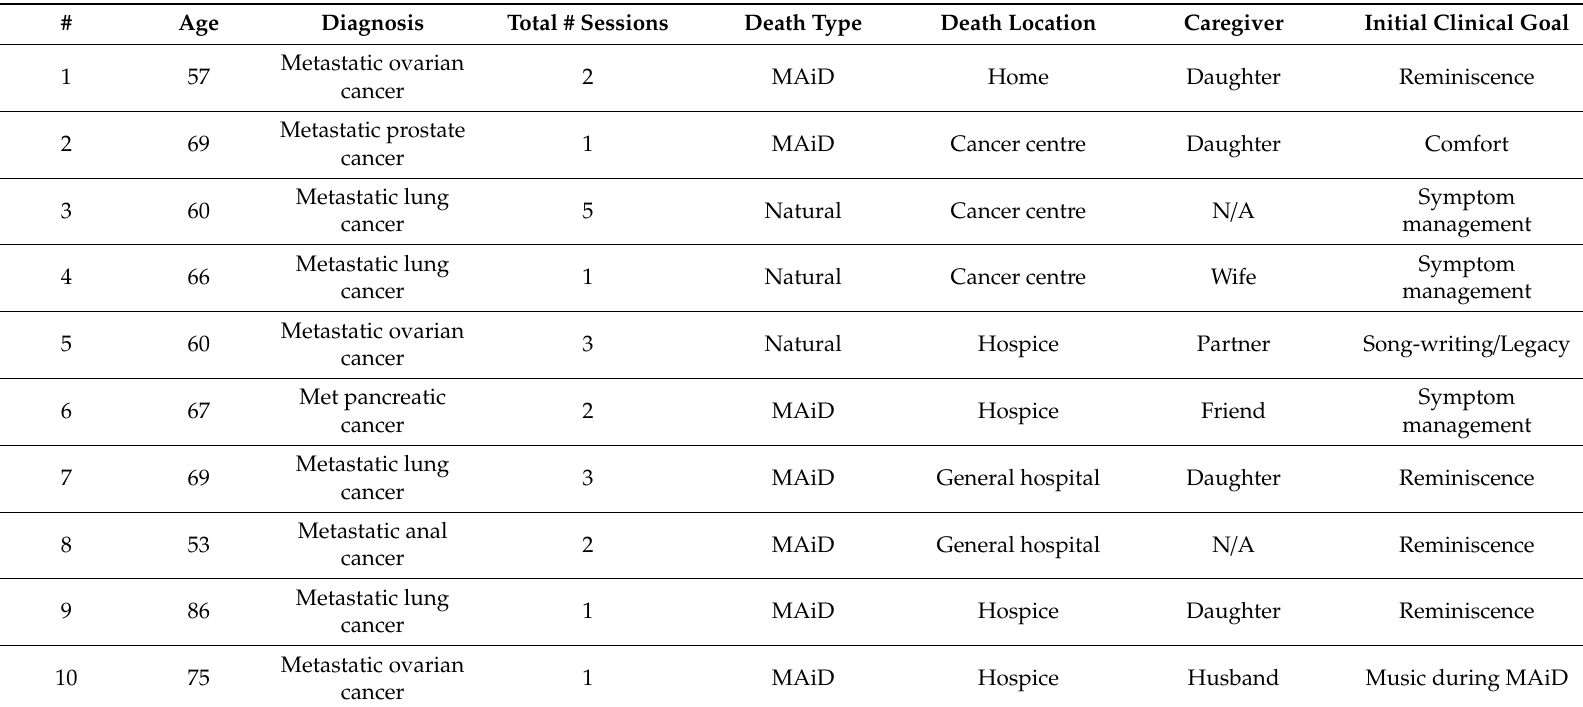
Table 1. An overview of patient participant